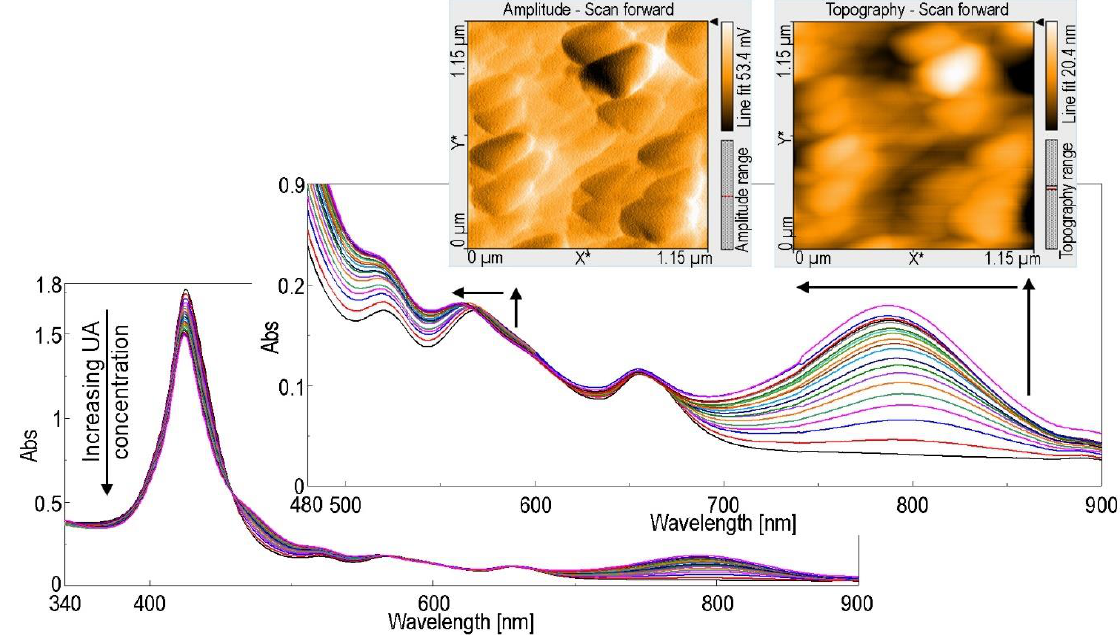
Figure 16. The UV-vis spectra registered by adding UA to TAmPP- Pt@CuNPs hybrid material in DMSO solution; AFM images of TAmPP- Pt@CuNPs hybrid material after exposure to UA.